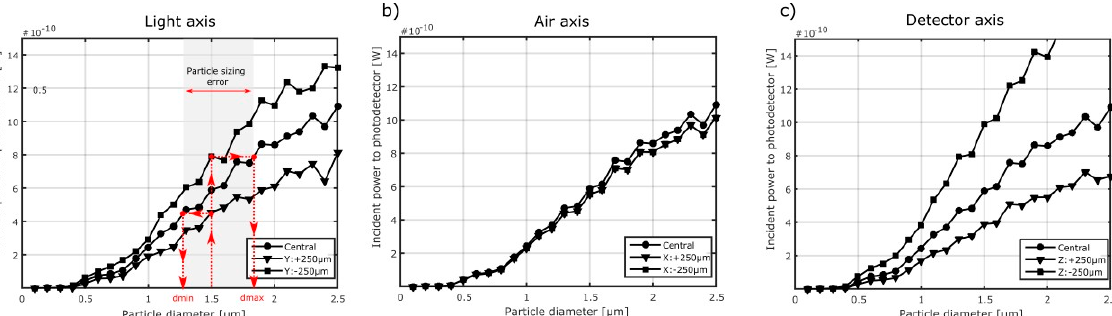
Figure 2 . Theoretical response for the nominal and two negative and positive extremal positions for ±250 µm displacement in the direction of the ( a ) axis of the laser source, ( b ) axis of the air stream and ( c ) optical axis of the detector. In ( a ), the estimation procedure of the particle sizing error is shown. For the sake of this simulation, we set the λ = 650 nm, input intensity to I 0 = 5 Kw/m 2 and the complex refractive index to m = 1.5 + i 0 .